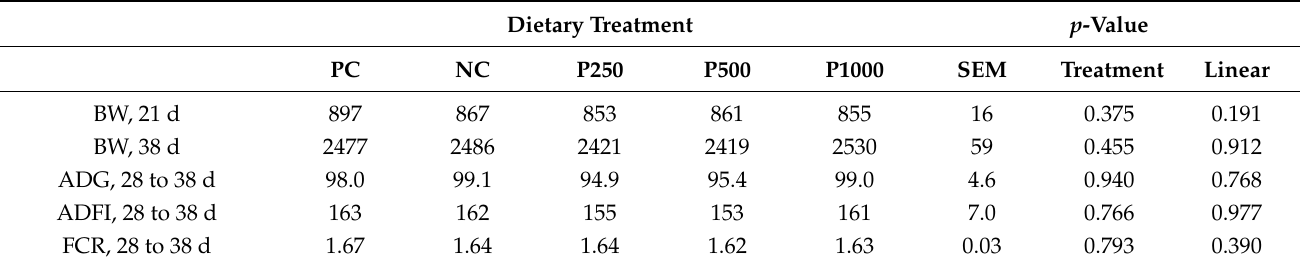
Table 2. Short-term trial: Initial and final body weight (BW, g), daily weight gain (ADG, g/d), daily feed intake (ADFI, g/d), and feed conversion ratio (FCR, g feed/g weight) of broilers fed feeds including different levels of phytase from 21 to 38 days of